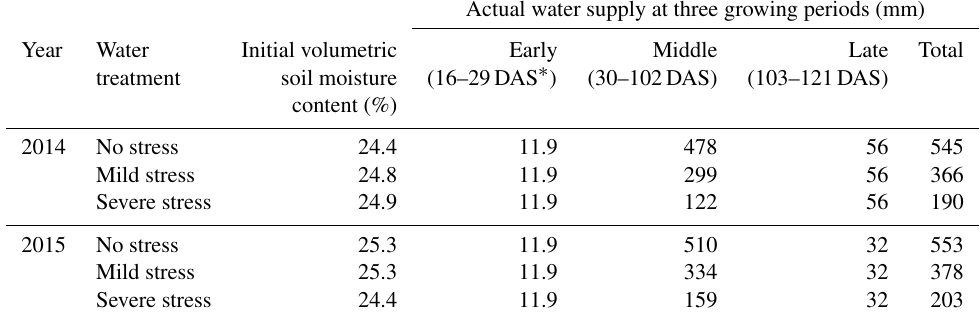
Table 1. Water treatments during crop-growing seasons from 2014 to